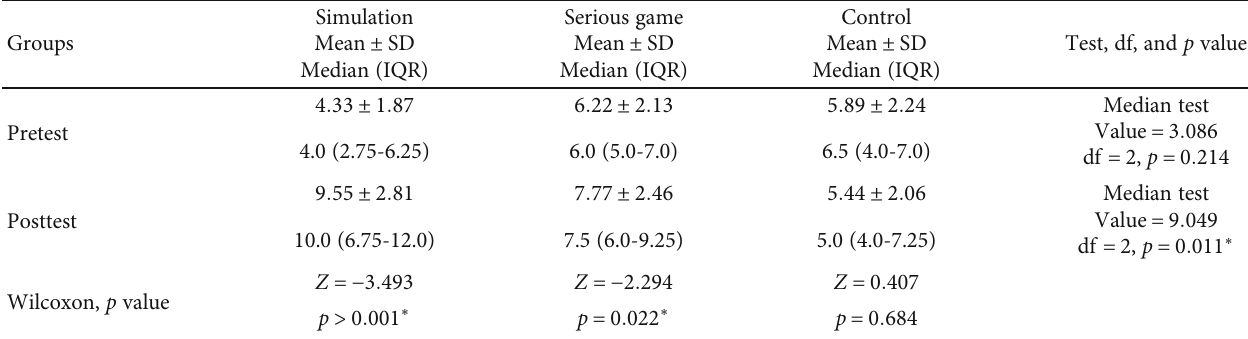
Table 2: Comparison of CPR knowledge across three study groups (simulation, serious game, and control). Groups